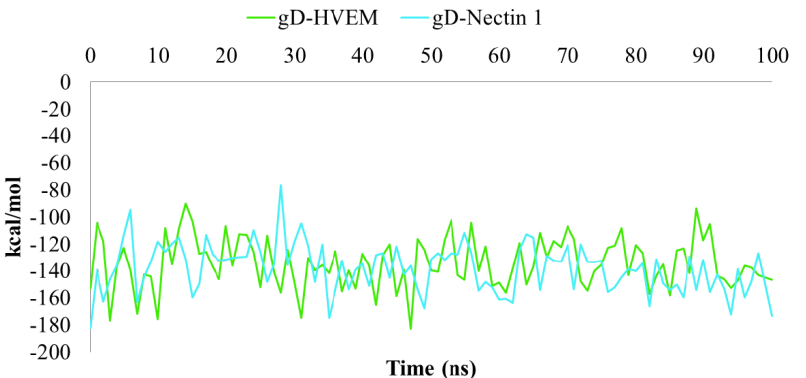
Figure 5. Plot of MM/GBSA trend for HVEM and Nectin-1 in complex to gD during 100 ns of MDs. After investigating the PPIs ’ structural details, we focused on the key residues of gD liable for the interaction with the analyzed human receptors to find potential ligands able to prevent the connection with them. According to the literature [40], several gD N-terminus residues at position 7 – 15 and 26 – 29 are responsible for the bind with HVEM, whereas two residues, such as Asp26 and Tyr38, also belonging to gD N-terminus, are relevant for the connection with Nectin-1 [41]. Apart from the shared Asp26 and Gln27 residues, both human receptors interact with different portions of gD. It was underlined that HVEM and Nectin-1 show non-reciprocal competition for binding to gD [42]. In- deed, the interaction between HVEM and gD induces a conformational change in gD that results in the formation of the N-terminal hairpin structure that masks the binding site of Nectin-1 [42]. Similarly, the interaction with Nectin-1 induces a new conformation of the gD N-terminus that prevents the HVEM binding [4]. Considering therefore that gD is not able to bind both receptors at the same time [41], we evaluated the possible conforma- tional changes of gD during MDs. As previously reported [43], MDs trajectories were clustered based on RMSD matrix using the average hierarchical clustering linkage method, obtaining three representative structures of gD. Taking into account that the pivotal interactions of gD with HVEM and Nectin-1 involve distinct residues, we used all three representative structures generated from each complex (Figure S4) as starting point for SBVS. Thus, we performed molecular docking simulations of an in-house small library of 12 [1,2,3] triazolo [4,5- h ] [1,6] naphthyridines ( 1 – 12 , Table 1) with their precursors [1,2,3] triazolo [4,5- b ] pyridines ( 13 – 18 , Table 1) on each binding site, separately, using the docking program Glide in SP mode. Additionally, with the aim of exploring the influence of electron-withdrawing and/or electron-donating substituents at N-3 and C-8 positions of the triazolo-naphthyridine core on gD-ligand interaction, a focused library of 63 tria- zolo [4,5- h ] [1,6] naphthyridines ( 19 – 81 , Table 1) was also designed, along with the cor- responding [1,2,3]triazolo [4,5- b ] pyridines ( 82 – 85 , Table 1). We calculated the average G-score value for each cluster, aiming to focus on the compounds able to better recognize both Pocket 1 and 2 (Table S3). From the docking results, it clearly emerged that the tricyclic [1,2,3] triazolo [4,5- h ] [1,6] naphthyridine moiety showed a lower ability to recognize both the binding pockets compared to the bicyclic triazolo [4,5- b ] pyridine derivatives. Furthermore, regardless of the electronic nature of the substituents at the N-3 phenyl ring of the triazolo-naphthyridine core, no significant differences could be observed. Concerning